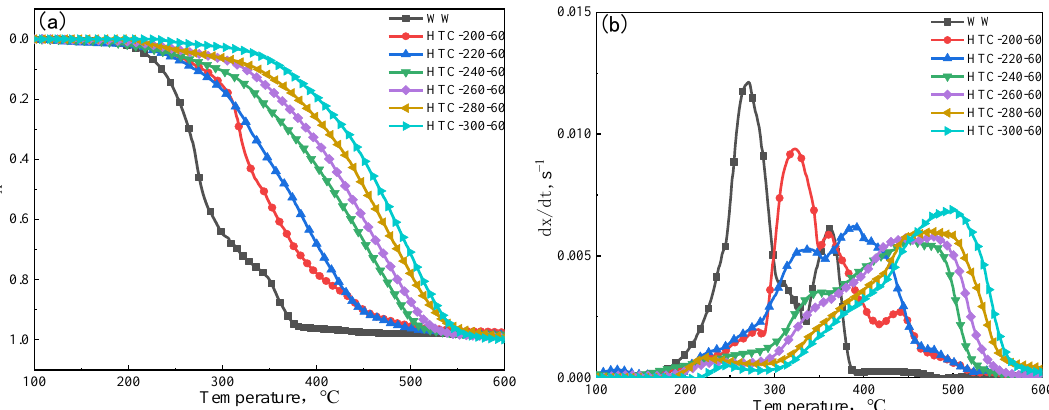
Figure 6. TG and DTG curves of WW and hydrochar under different HTC temperatures: ( a ) TG curves; ( b ) DTG curves.